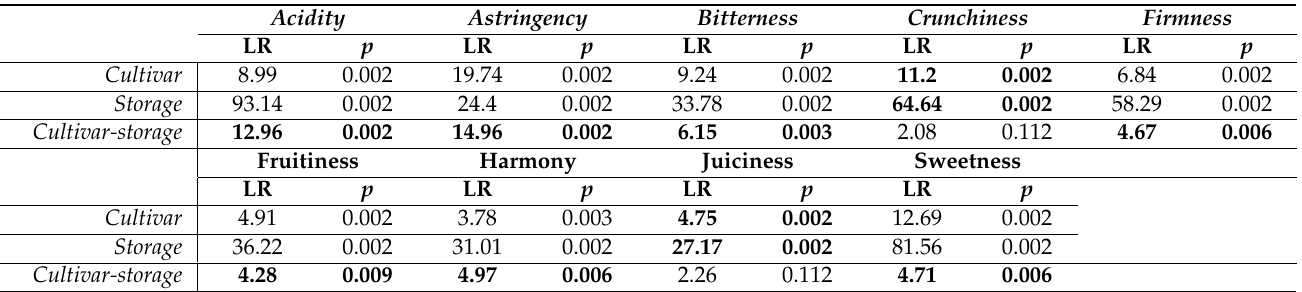
Table 3. Univariate test results from the manylm model regressing cultivar and storage treatment against peach sensorial